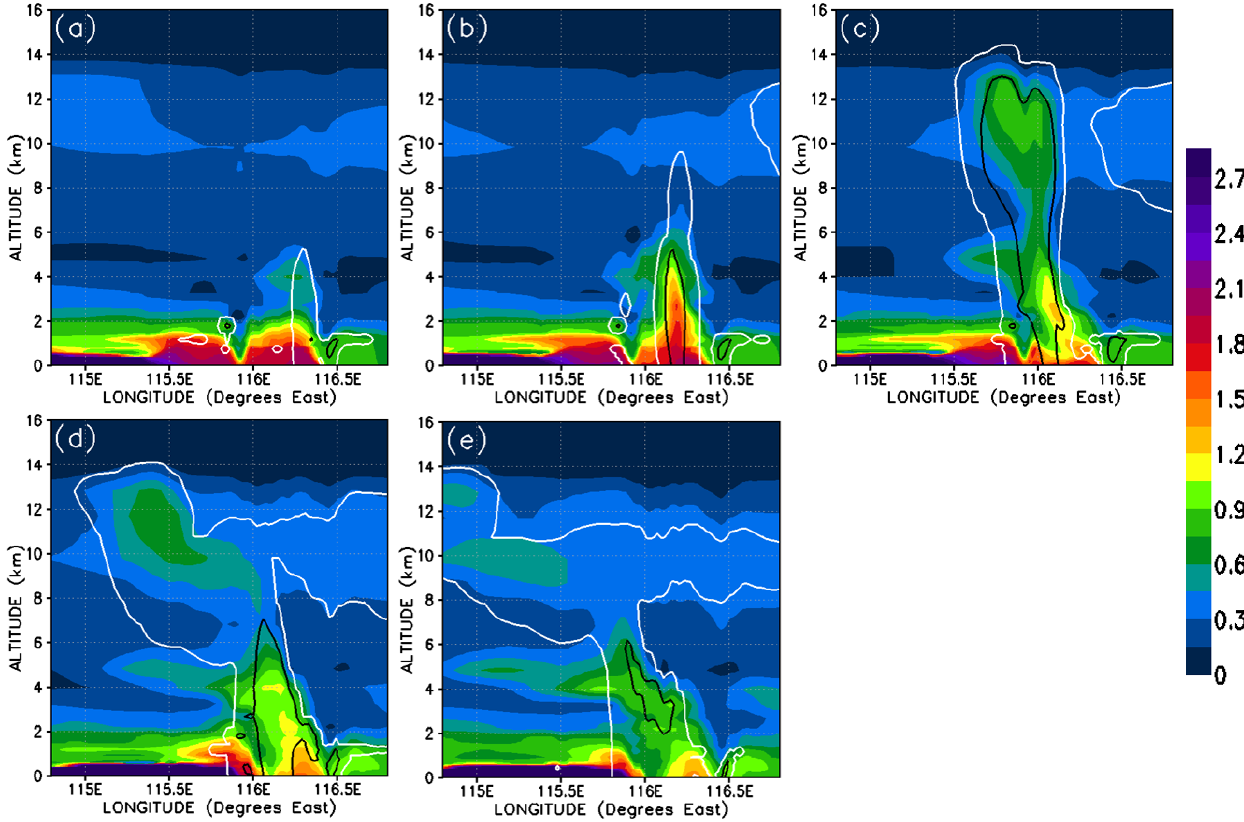
Figure 8. Vertical cross section within the most active part of Mod_Conv_5.4N convective system (located at 5.4 ◦ N) showing time evolution of CHBr 3 mixing ratio in parts per trillion by volume for 07:00, 08:00, 09:00, 10:00, and 11:00UTC. The white and black lines represent the 0.01 and 0.5gkg − 1 contour of the simulated condensed water (cloud and precipitation in ice and liquid